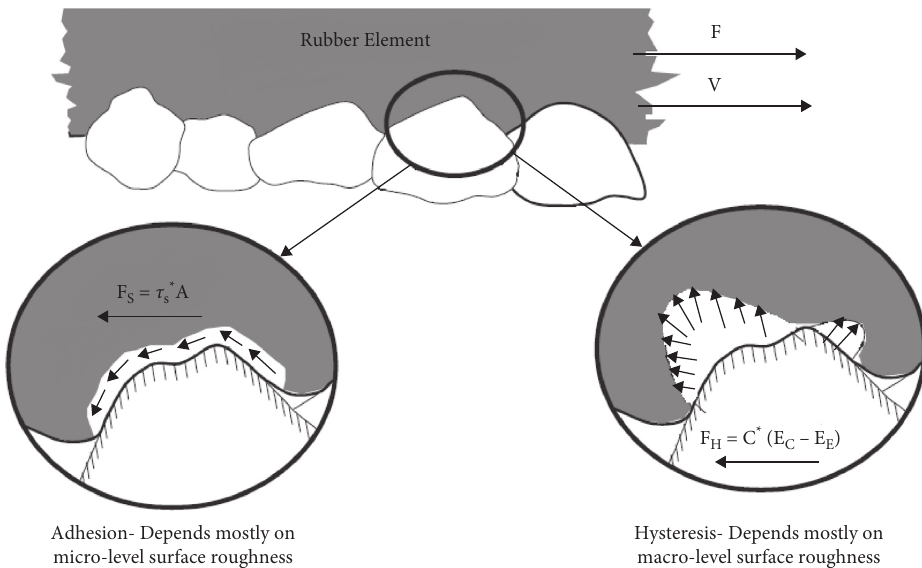
Figure 2: Schematics of adhesion and hysteresis [17]. Table 1: Direct measuring methods of pavement skid resistance in laboratories